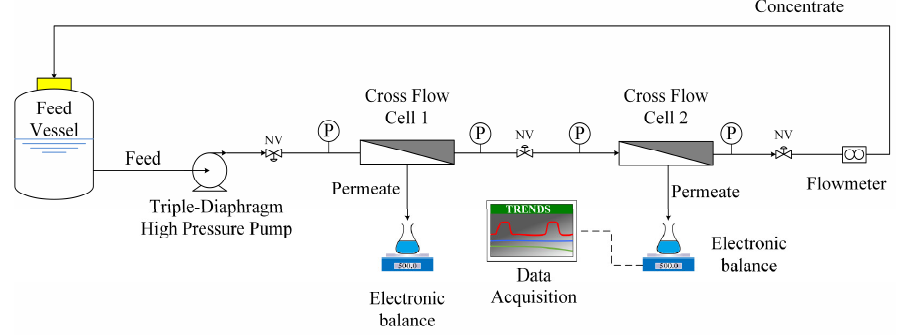
Figure 2. Experimental set-up employed in membrane filtration tests, in the cross-flow mode.